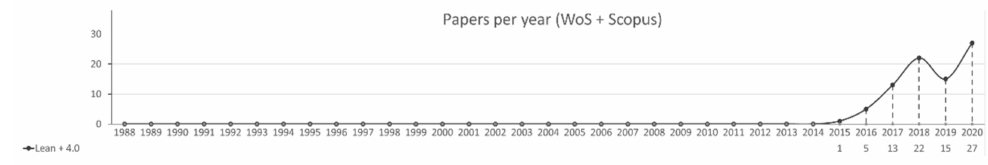
Figure 19. Papers about relationships between lean and Industry 4.0.